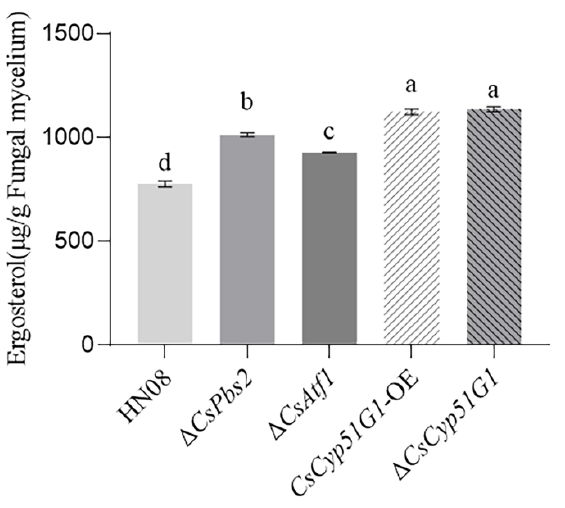
Figure 7. Ergosterol content in HN08, ∆ CsPbs2 , ∆ CsAtf1 , CsCyp51G1-OE, and ∆ CsCyp51G1 . The error bars show the SD values, and different letters (a, b, c, d) represent significant difference at p < 0.01 (One-way ANOVA and Duncan’s test ).